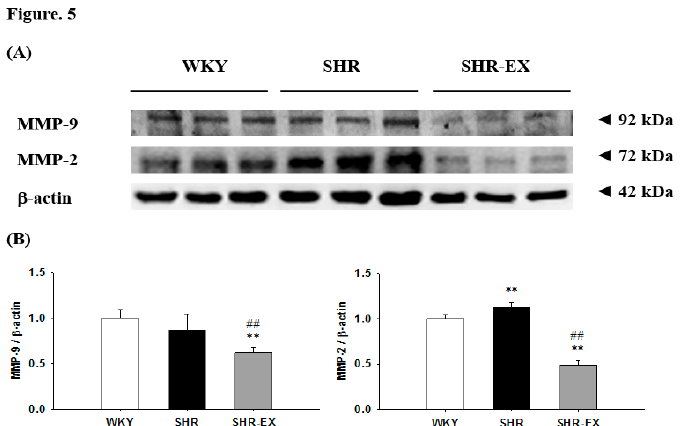
Figure 5. ( A ) The representative protein products of matrix metalloproteinase-9 (MMP-9) and matrix metalloproteinase-2 (MMP-2) extracted from the renal cortex of excised kidneys of Wistar-Kyoto rats (WKY), sedentary spontaneously hypertensive rats (SHR), and spontaneously hypertensive rats with exercise training (SHR-EX), as measured by Western blot analysis; ( B ) the bars represent the relative protein quantification of MMP-9 and MMP-2 on the basis of β -actin and indicate mean values ± SD (n = 8 in each group). ** p < 0.01 significant difference compared with WKY. ## p < 0.01 significant difference between the SHR group and SHR-EX.